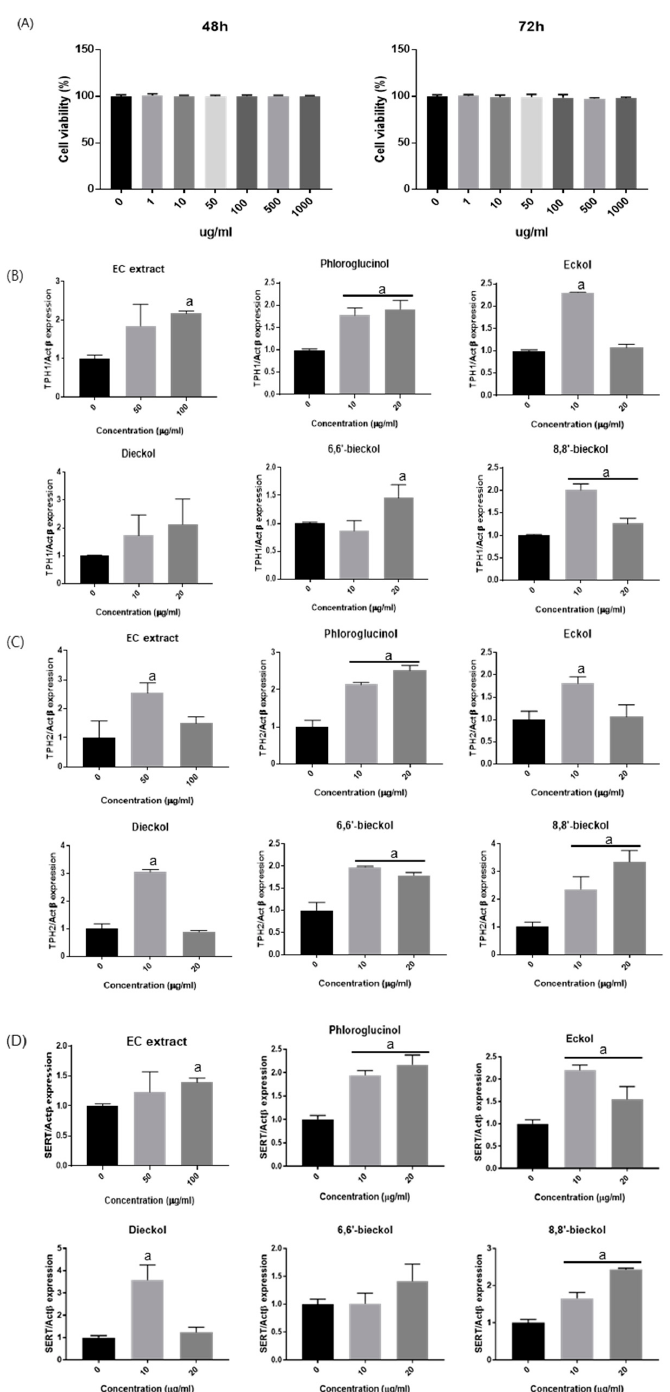
Figure 4. Cytotoxicity effect of EC on RBL-2H3 cells and the effect of EC and its major constituents on the mRNA expression of serotonin synthesis enzymes and serotonin transporter. ( A ) Cell viability of RBL-2H3 treated with various concentrations of each component for 48 and 72 h. A total of 1 × 10 3 cells were plated into 96-well plates and then EC was added at different concentrations. After 48 and 72 h, the cells were incubated with MTS for 3 h. Absorbance was recorded at 490 nm. ( B – D ) Comparison of serotonin-related mRNA expression levels between control condition (non- treated) or treated with EC for 48 h. ( B ) TPH-1, ( C ) TPH-2, and ( D ) SERT mRNA expressions were tested using RT-PCR in the RBL-2H3 cell line. Experiments were conducted in triplicate and data are expressed as means ± SD. a p < 0.05 versus the control